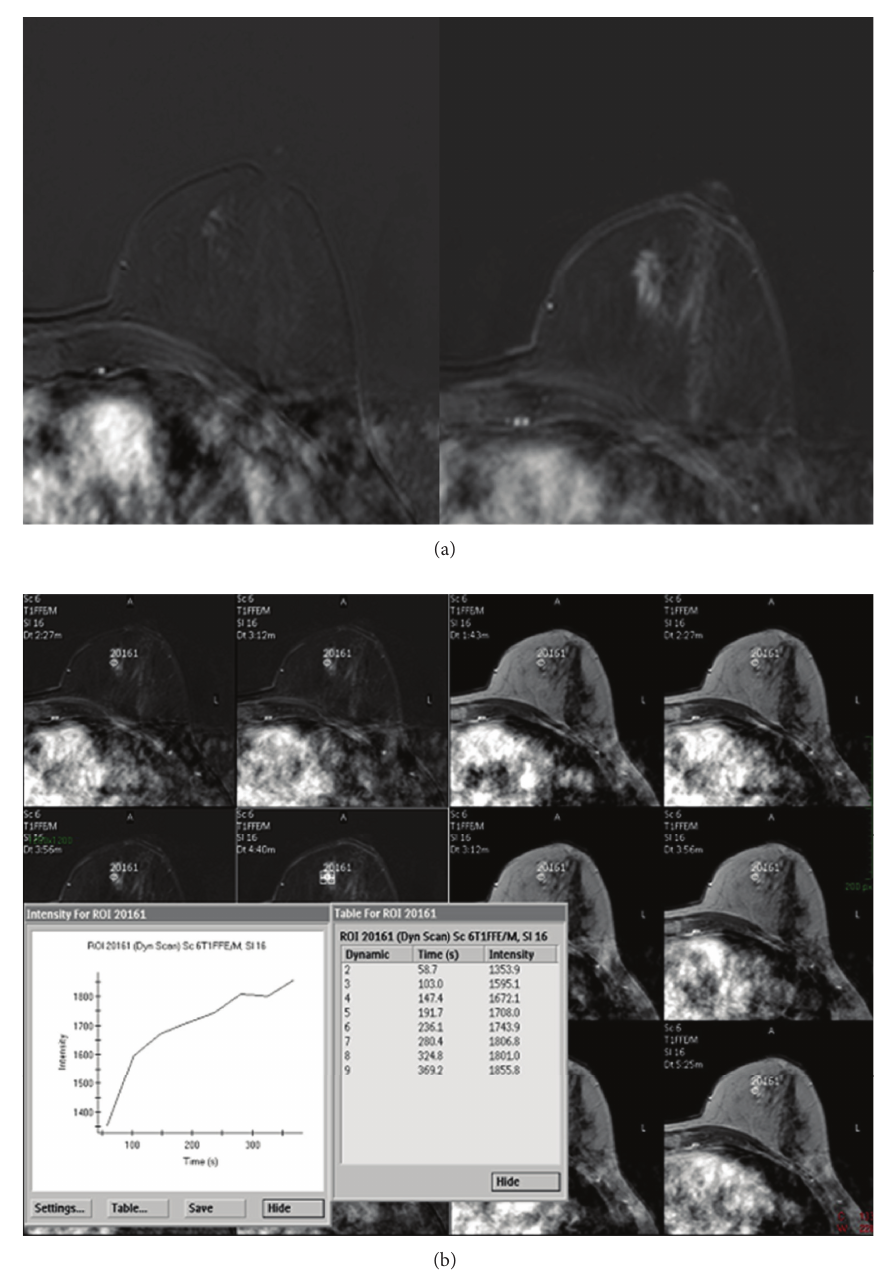
Figure 4: (a) Early and late dynamic contrast-enhanced sequences show a slow and progressive contrast enhancement of the left nipple extending to subareolar region. (b) The time-signal intensity curve appears slow and